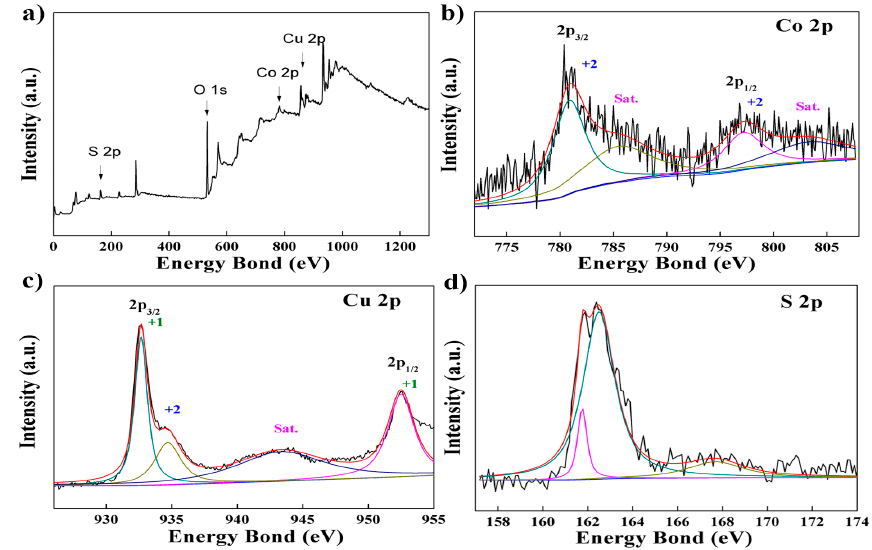
Figure 2. ( a ) The full-survey scan spectrum of P–Cu–Co sulfide; ( b ) high resolution spectra of Co 2p; ( c ) high resolution spectra of Cu 2p; ( d ) high resolution spectra of S 2p.